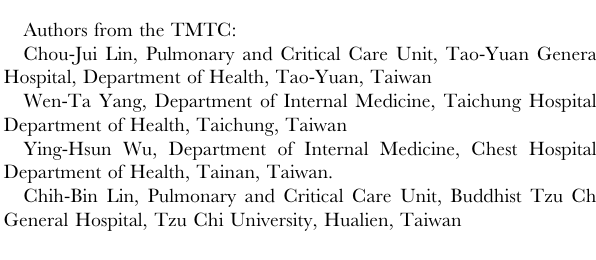
Table S3 Prognostic factors associated with treatment success for 340 patients (excluding 311 patients in pre- TMTC era with treatment results in TMTC